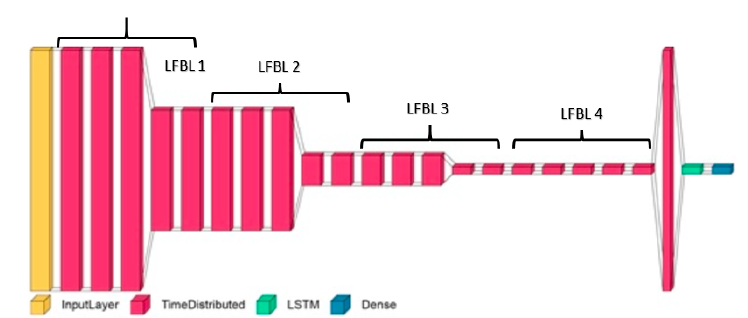
Figure 3. Abstract depiction of the layers in the classifier model used in the